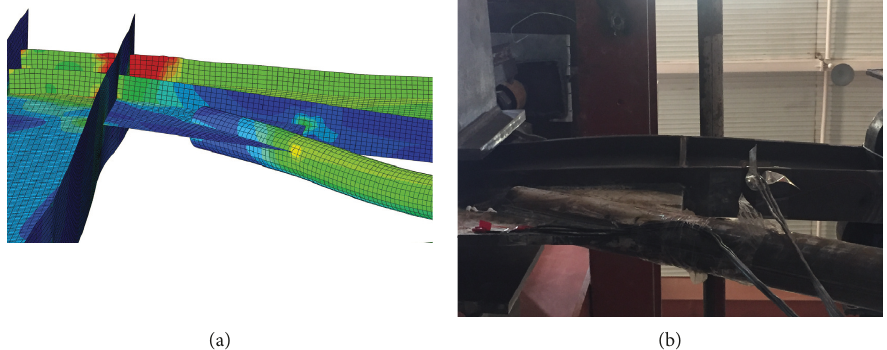
Figure 17: Plastic hinge of the beam end (second floor). (a) FEM result. (b) Test phenomenon.